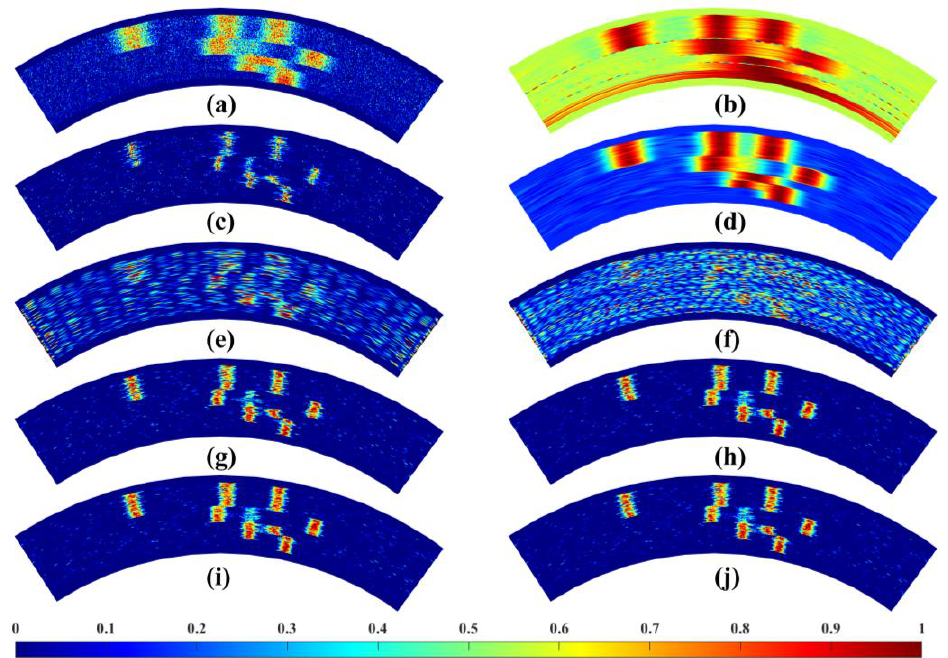
Figure 11. Restored results of simulated surface targets with convolution and noise degradation when the SNR of noise is 5 dB. ( a ) Blind deconvolution. ( b ) Regularized Filtering. ( c ) Richardson–Lucy. ( d ) Wiener Filtering. ( e ) TSVD. ( f ) SDBSM. ( g ) TV. ( h ) TV BC. ( i ) TVS. ( j ) TVSBC.